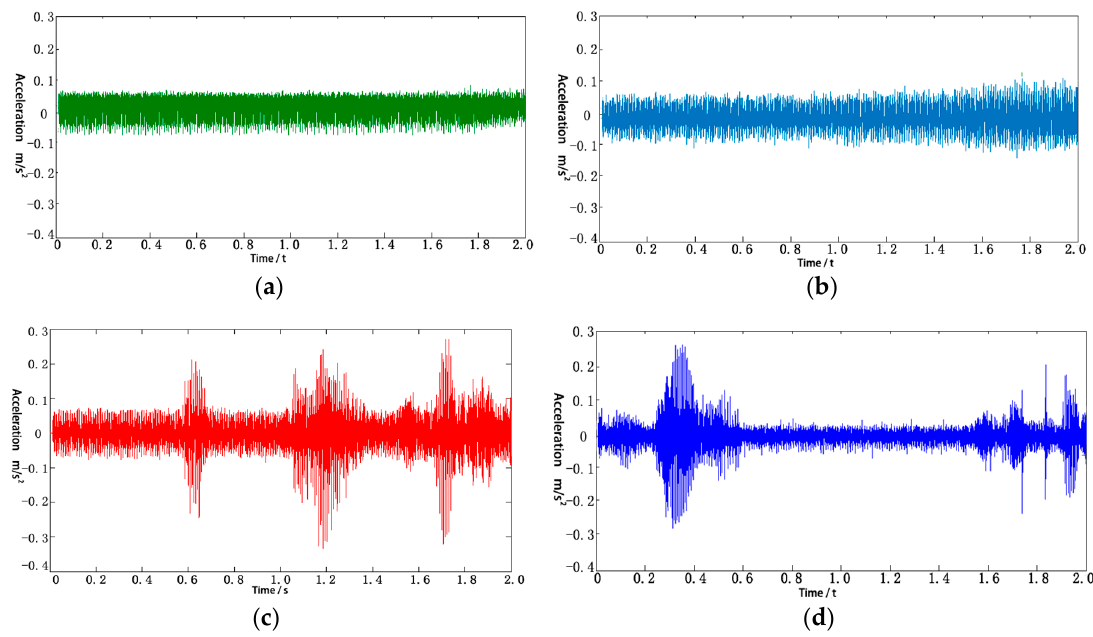
Figure 16. Time-domain diagram of vibration-acceleration signals at measurement point 1 under various working conditions: ( a ) normal working conditions; ( b ) insulation shedding; ( c ) winding loosening; ( d ) winding deformation.